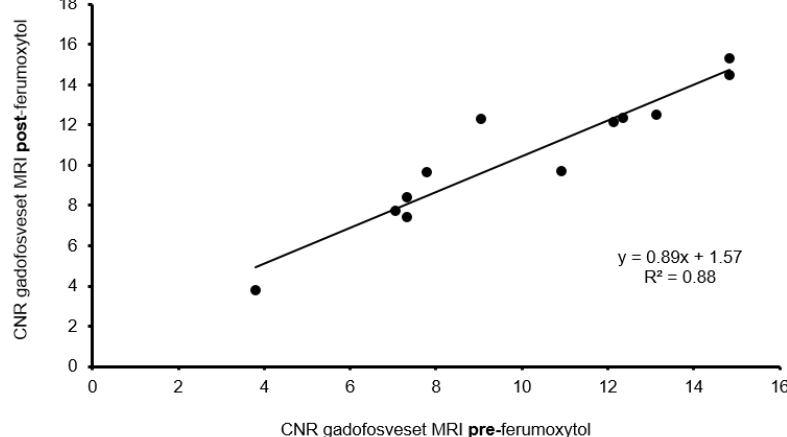
Figure 5. Ferumoxytol impact on T1-weighted MRI with gadofosveset. T1-weighted MRI using serum albumin contrast agent was performed before and 24 h after iron oxide particle administration ( n = 3/group). The pronounced correlation of CNR pre- and post-iron oxide particle administration rules out a negative influence on the serum albumin probe.